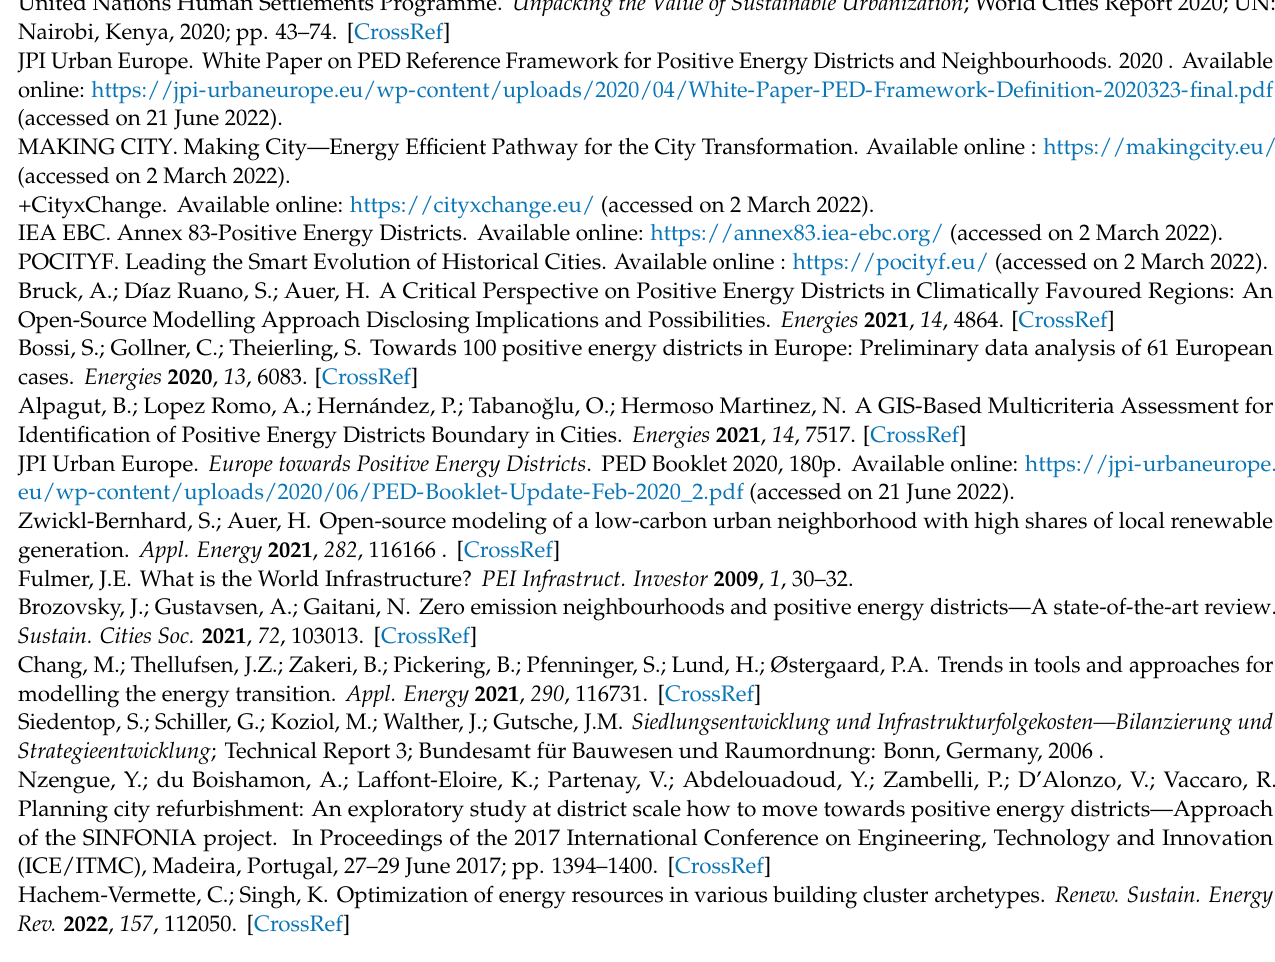
Let us consider an example in which a pixel on the map (i.e., one hectare) has a final heat demand that is indicated by A, a total gross floor area of B and a percentage of residential GFA of C. The resulting pixel on the visualisation map would have the value of the product of their prime number indicators (in this case, 638). Because this number can only be derived from the multiplication of these three prime numbers, each pixel can be unequivocally identified and